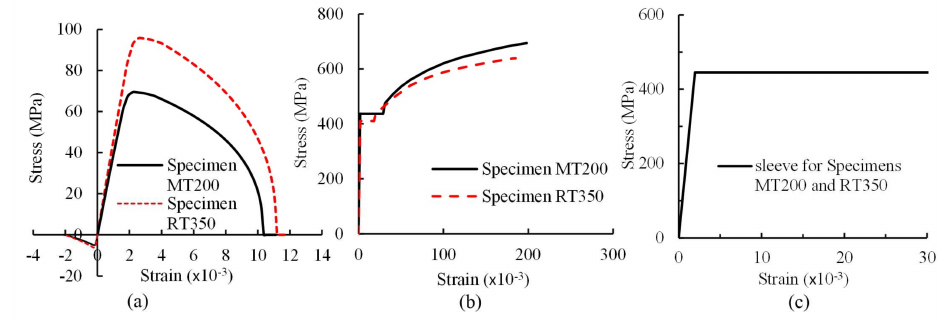
Figure 13. Material models for ( a ) grout; ( b ) steel profiles; and ( c )